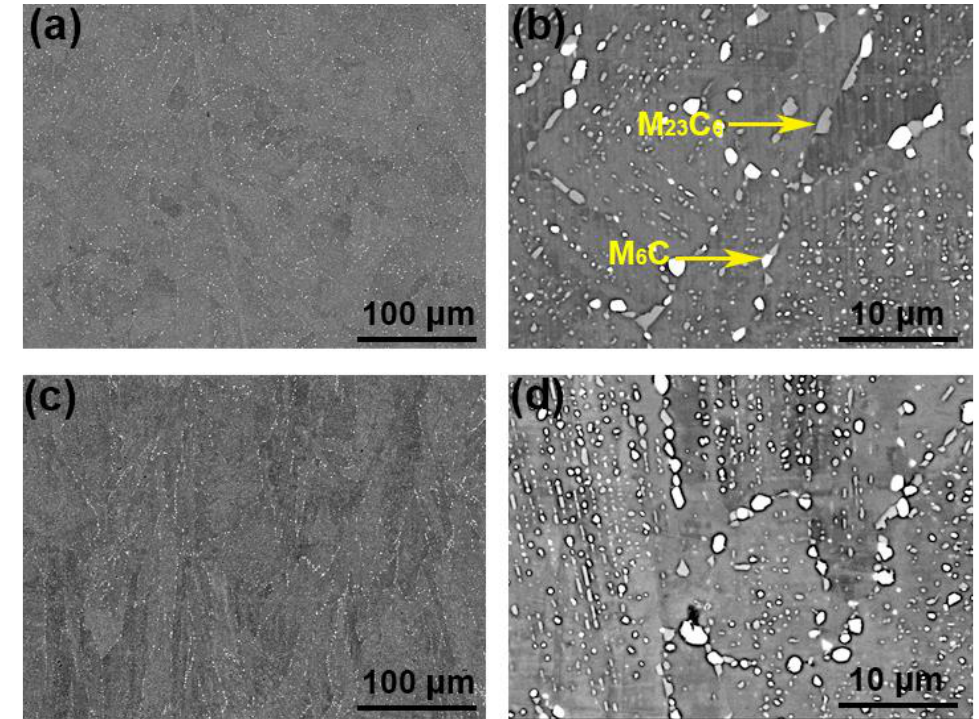
Figure 5. The SEM images of the CRHA. ( a , b ) the vertical view of the CRHA, ( c , d ) the horizontal view of the CRHA.